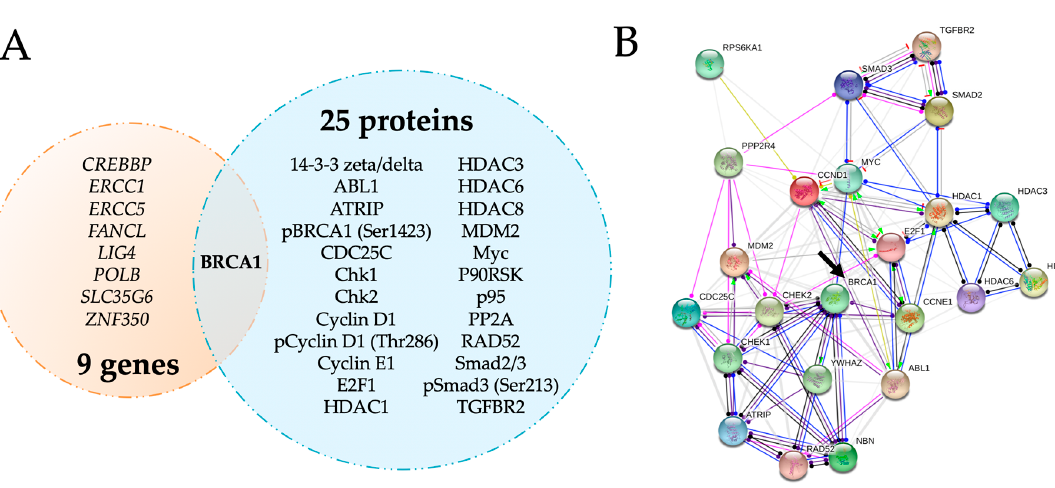
Figure 2. Central role of placental BRCA1 in the first trimester of pregnancy in the context of maternal obesity. Venn diagram depicting cell cycle genes and proteins regulated by maternal obesity (BMI ≥ 30 kg / m 2 ) in the first trimester of pregnancy with BRCA1 as the only common factor ( A ). Protein–protein interaction analysis of the upregulated proteins using the STRING database shows a central role of BRCA1 in the cell cycle regulation network ( B , arrow). Line shape indicates the predicted mode of action, with nodes describing protein action e ff ects (arrow: positive, dash: negative, circle: unspecified) and line color describing protein action types (blue: binding, black: reaction, green: activation, red: inhibition, pink: posttranslational modification, violet: catalysis). The minimum required interaction score was set to medium confidence (0.4), showing up to 10 interactions in the first shell.